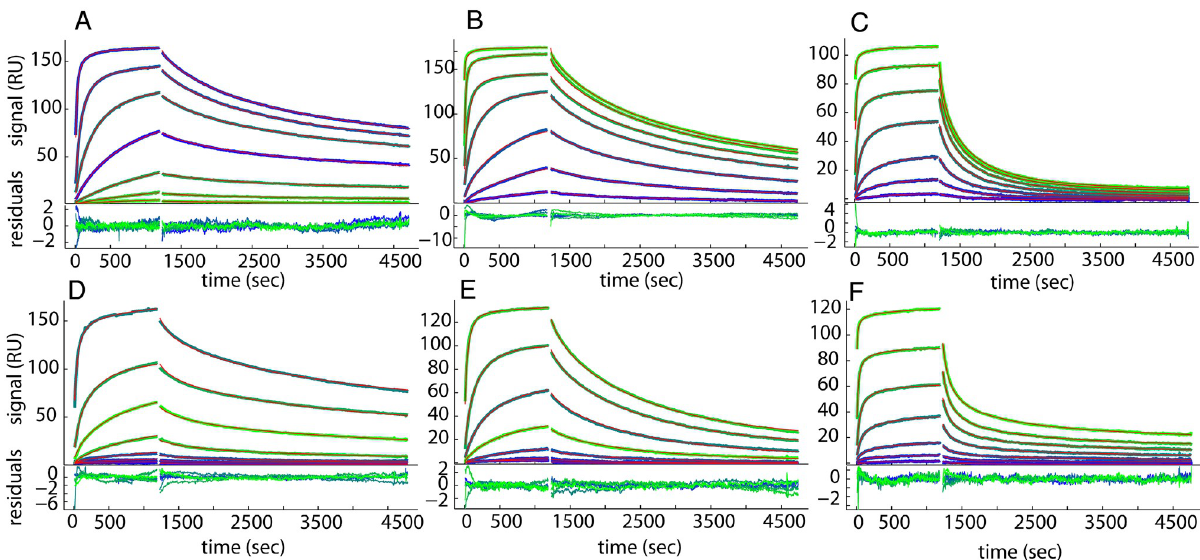
Fig 6. Representative sensograms showing binding of monoclonal antibodies (Fab) to HT core immobilized on the CM5 sensor surface. SPR binding data (blue/green lines: 0.3, 1, 3, 10, 30, 100 and 500 nM) and best-fit (red lines, superimposed by the blue/green lines) from the surface site distribution model in EVILFIT. For each panel, the binding traces and best-fit are shown on the top and the residuals of the fits are shown on the bottom. (A) Fab B6, (B) Fab E6, (C) Fab B2, (D) Fab D5, (E) Fab G4, (F) Fab C7. In spite of the narrow range of K d values as shown in Table 1, the binding kinetics appear to be distinctive as shown from dissociation phase (1200–4800 seconds), with Fab B2 and Fab C7 showing faster dissociation than the other Fab molecules.